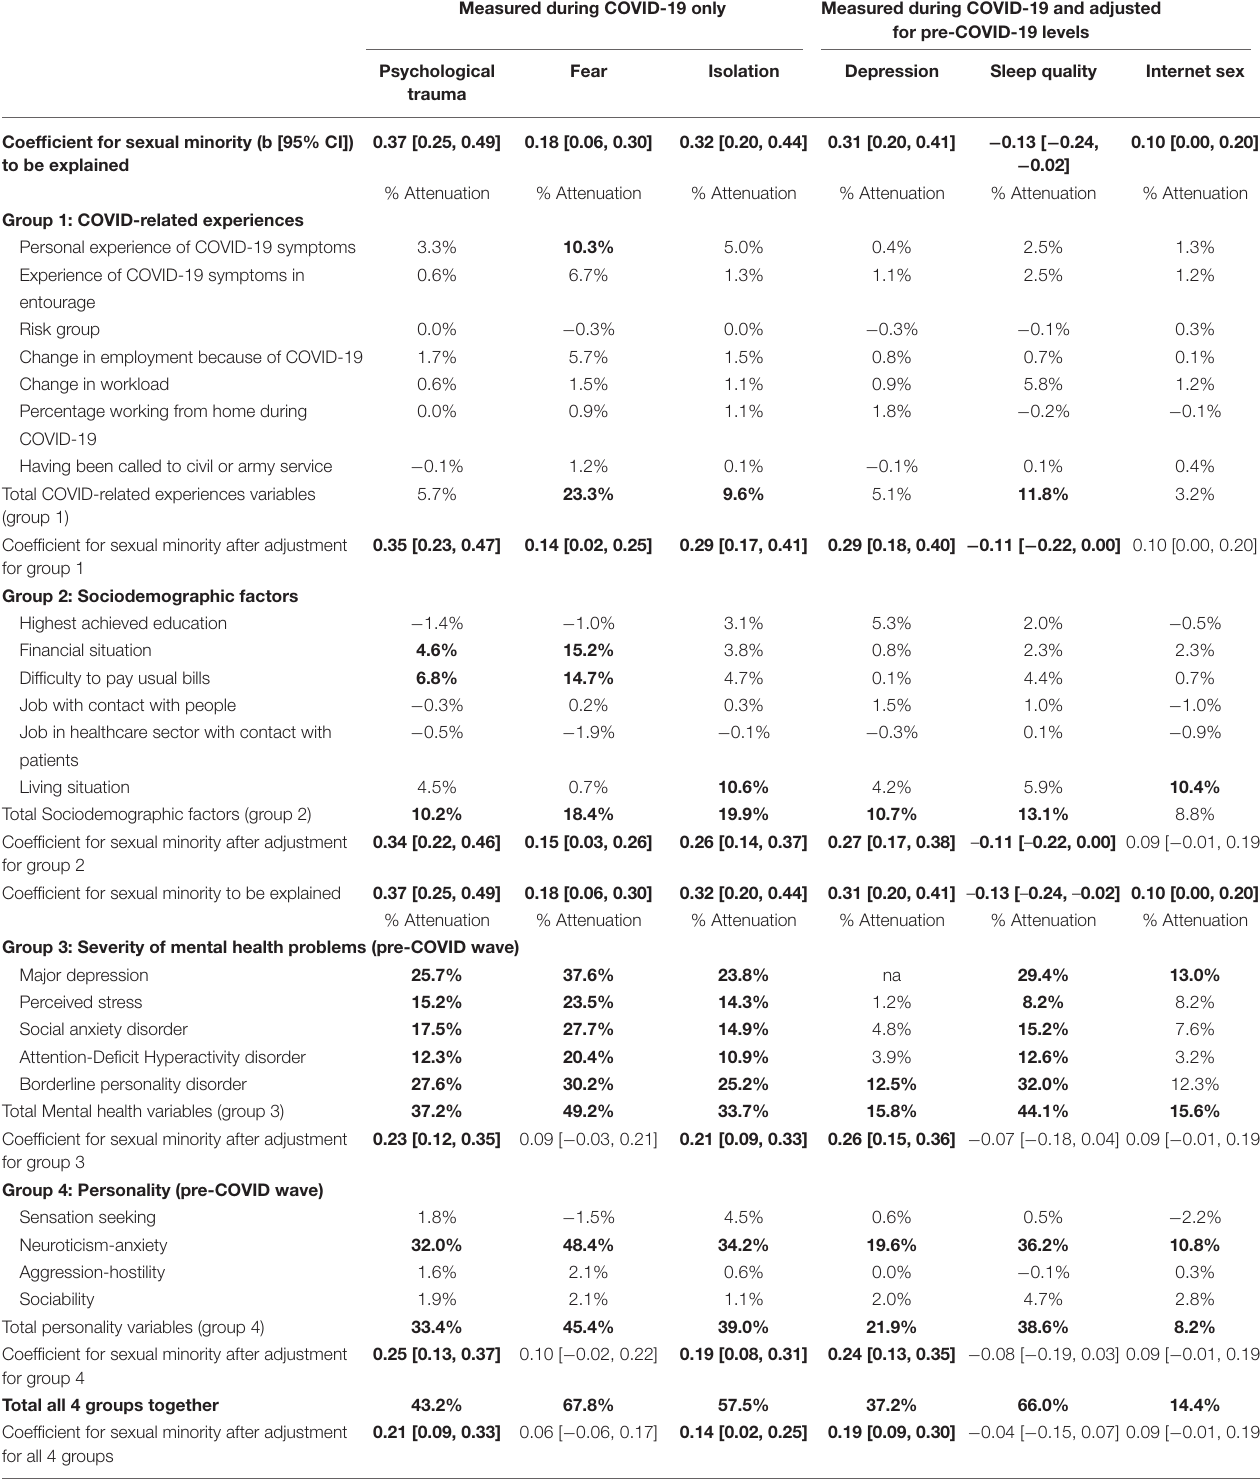
TABLE 4 | Percentage of attenuation/reduction in the coefficients of outcomes with significant associations with sexual minority orientation, after adjustment for COVID-related experiences, sociodemographic factors, mental health and personality. Measured during COVID-19 only Measured during COVID-19 and adjusted for pre-COVID-19 levels Psychological Fear Isolation Depression Sleep quality Internet trauma